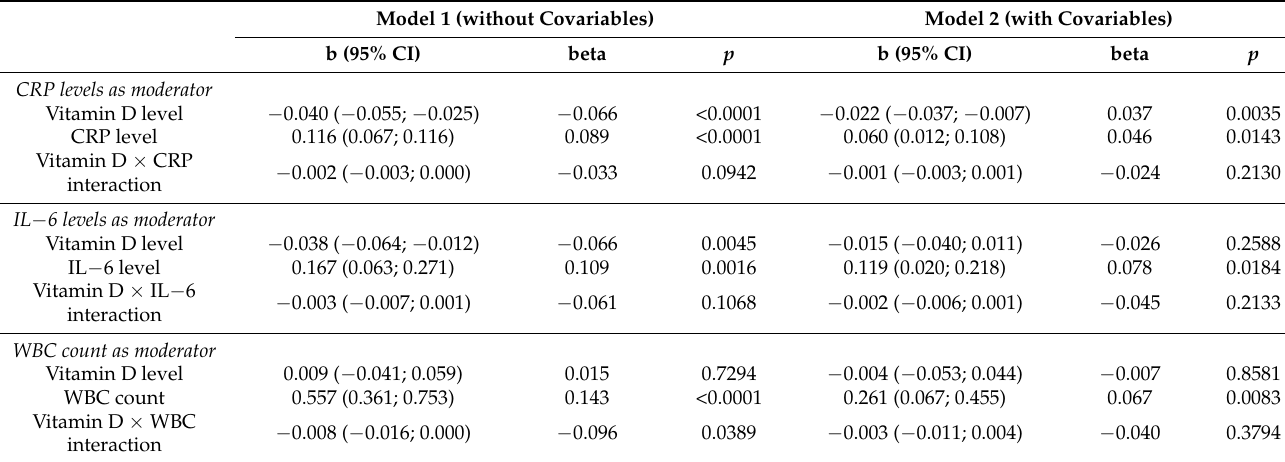
Table A1. Results of regression analyses regarding the role of inflammation parameters (CRP, IL-6, WBC) as possible moderator for the association of vitamin D concentrations and depression (CES-D